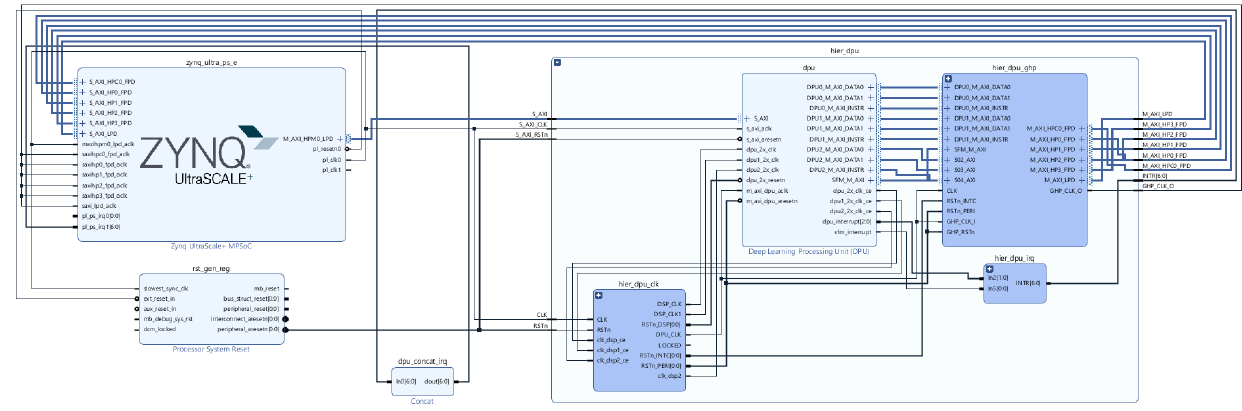
Figure 5. Hardware Design of DPU connected to the PS